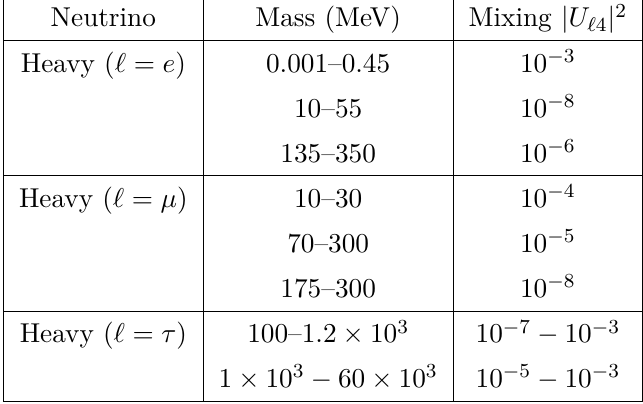
Table 3. Experimental constraints on a heavy neutrino mixing [53, 54].